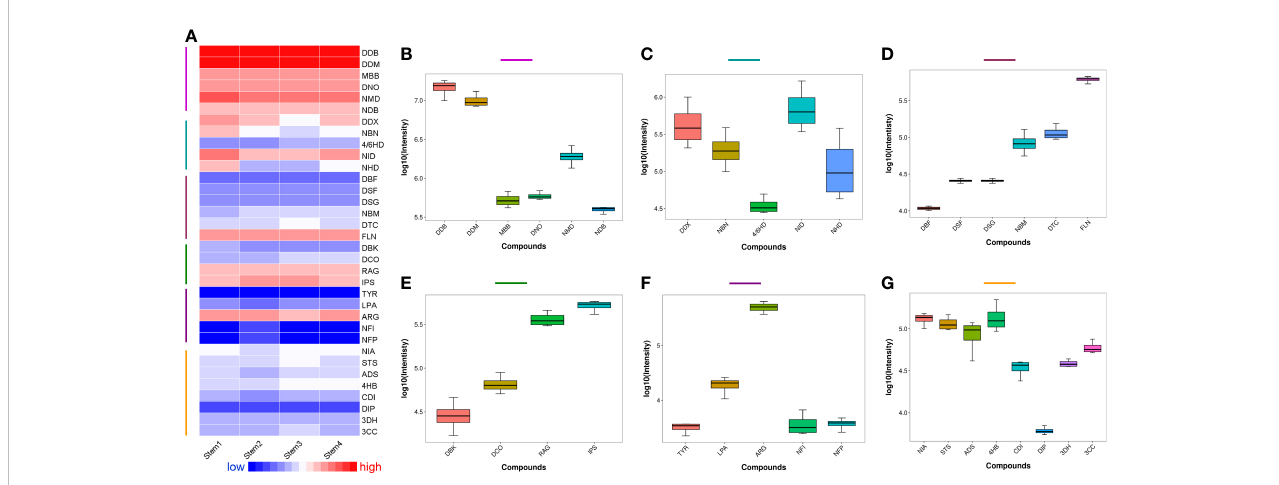
FIGURE 2 Relative content of the identi fi ed metabolites, including alkaloids and sesquiterpenes, from the mature stems of Dendrobium nobile . (A) heatmap for full view; (B) dendrobine-type alkaloids; (C) dendroxine-type alkaloids; (D) dendrobine-type sesquiterpenes; (E) other types sesquiterpenes; (F) : amino acid; (G) : other metabolites; All the full names of identi fi ed metabolites could be found in Table